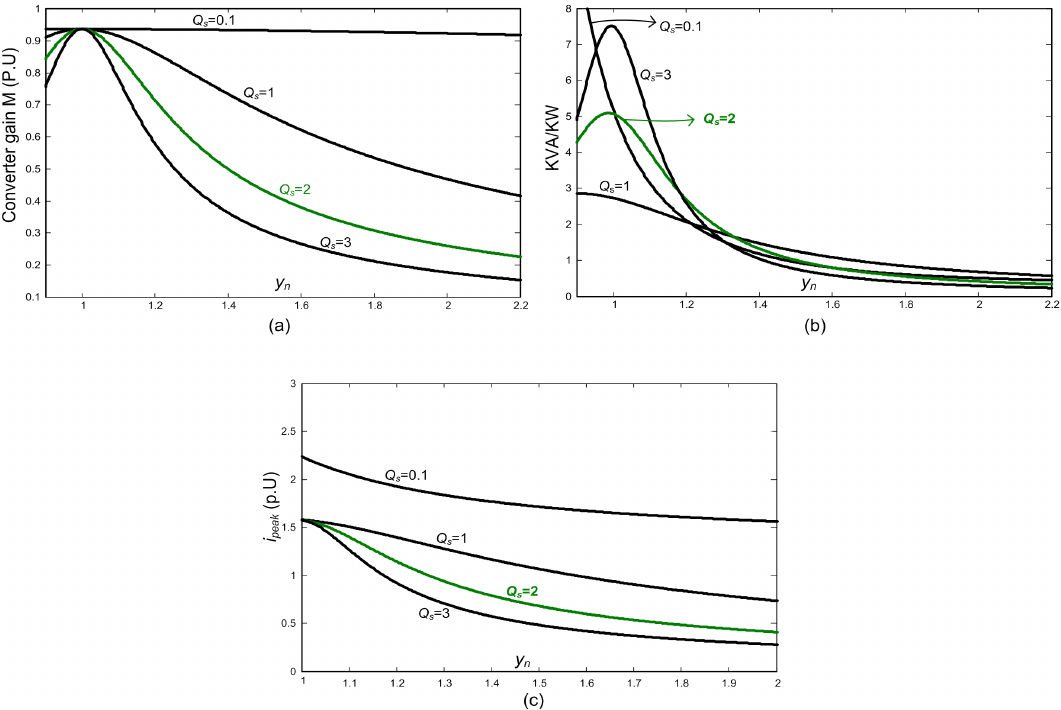
Figure 4. Design curves of LCLC resonant converter at L s / L p = 0.1, C s / C p = 2. ( a )